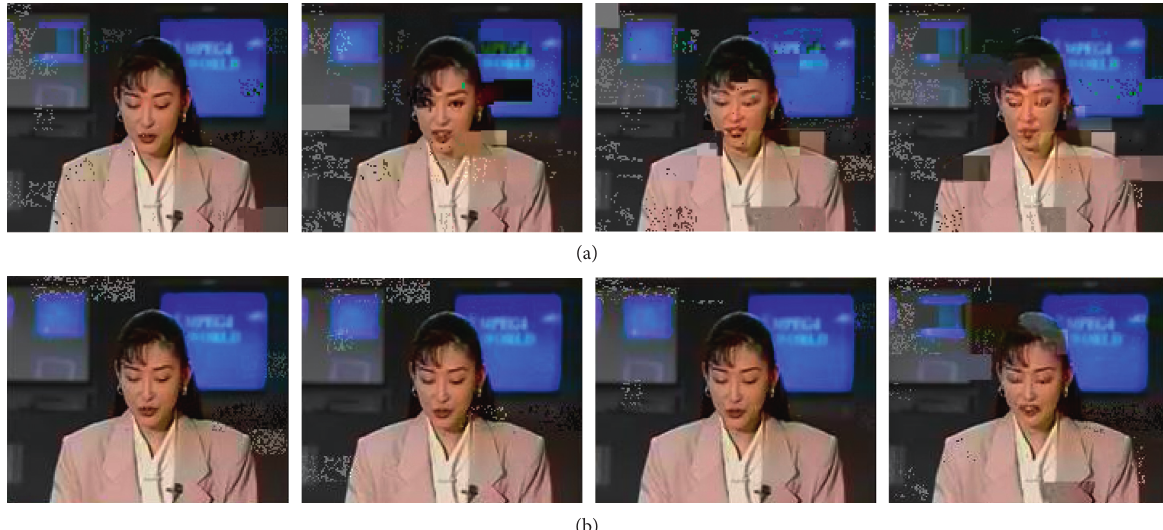
Figure 16: Subjective video quality performance of (a) Mapping-I and (b) Mapping-II CSM schemes at E